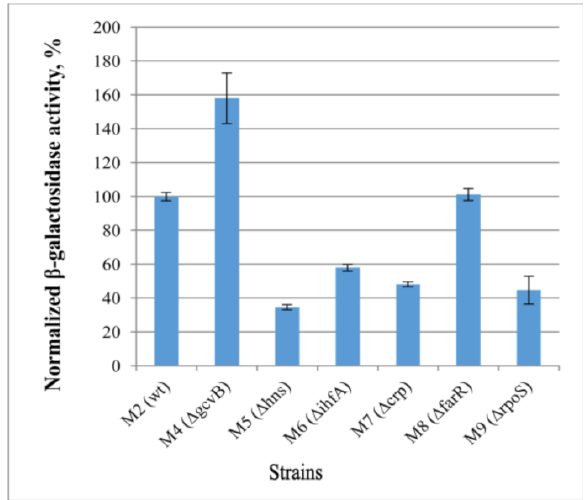
Figure 6. Influence of deletions of various regulatory factors on the expression level of lacZ gene under control of the P cycA regulatory region. The initial strain M2 (MG1655 cat -P cycA - lacZ ) and its derivatives lacking various transcriptional regulators (M4–M9) were incubated in LB medium at 37 ◦ C, and the β -galactosidase activity was measured at the exponential growth phase. The values were normalized at the activity level of the M2 strain. The data are the mean values of three independent experiments, where each assay was performed in triplicate, shown with standard deviations.